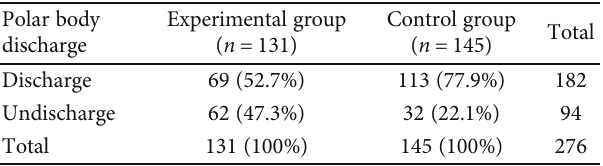
failure in the experimental group (spindle defects: 64 : 67 ± 1 : 16 % vs. 9 : 27 ± 2 : 28 % control; chromosome misalignment: 50 : 80 ± 2 : 40 % vs. 8 : 30 ± 1 : 16 % control) (Figure 5). Spindle defects included spindle elongation and spindle irregularity.